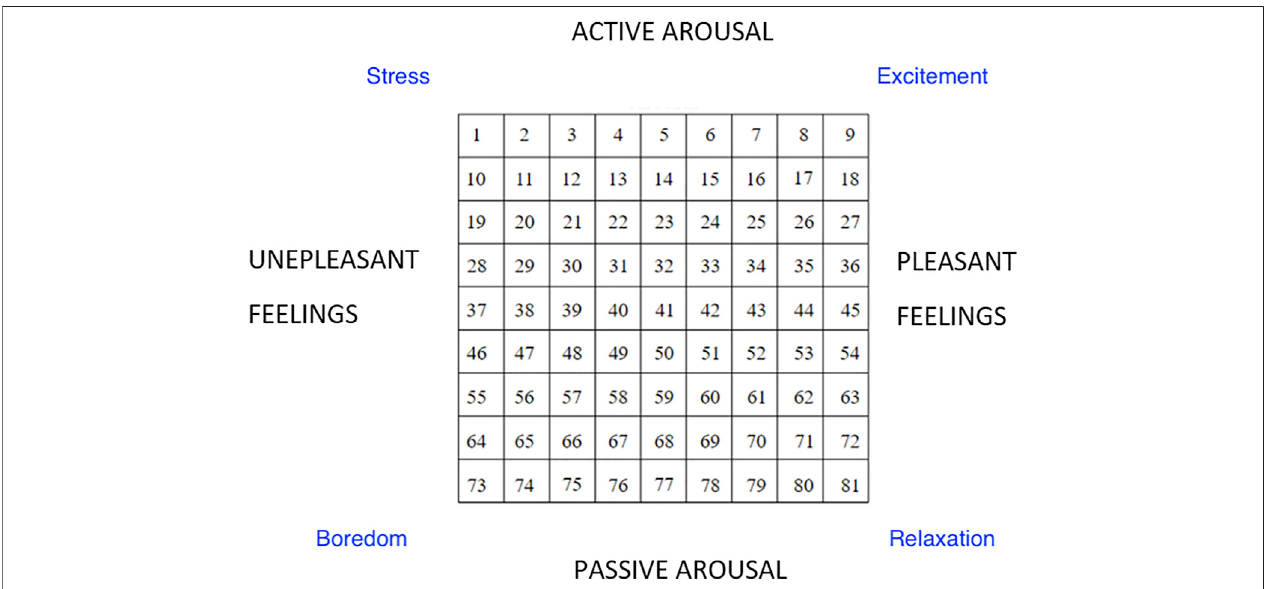
FIGURE 3 | Illustration of the numerical grid used to self-guide the evaluation of an individual ’ s affective state at a given moment in time.